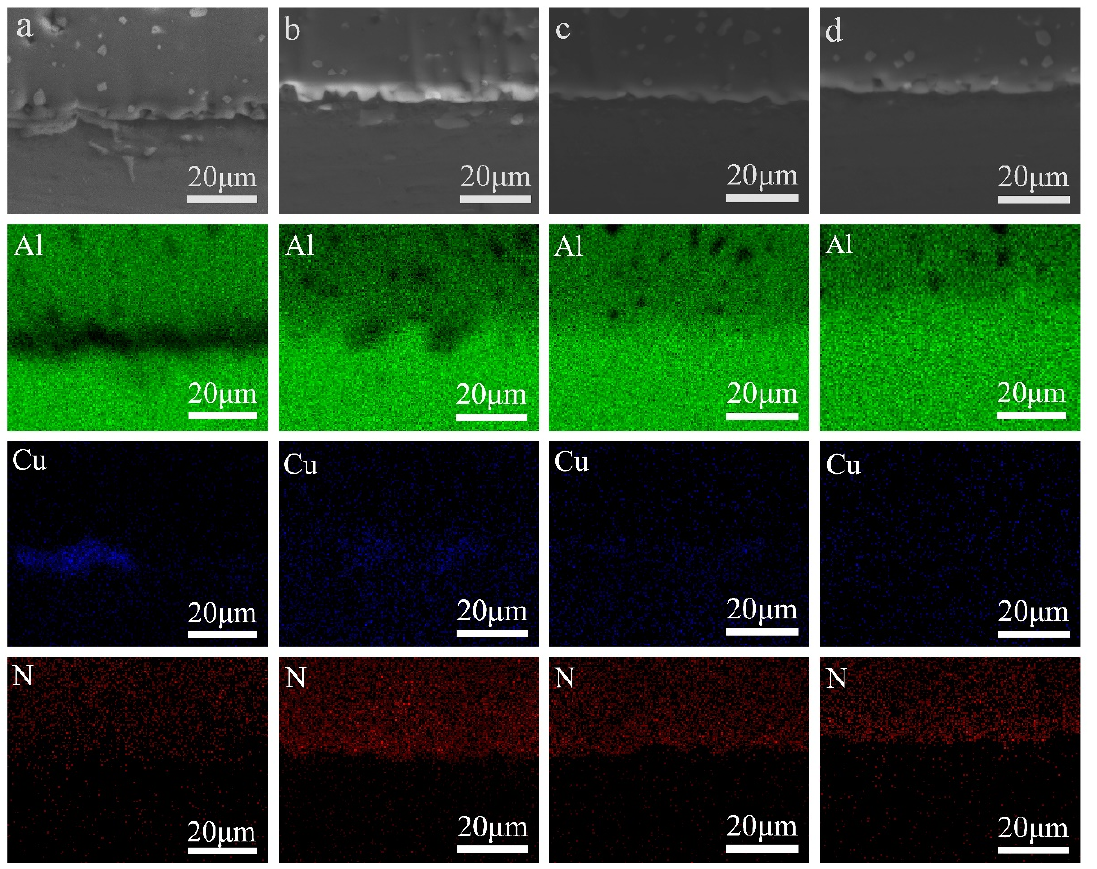
Figure 6. Scanning electron microscope images and scanning results of Al, Cu and N elements of brazed joints at different temperatures ( a ) 600 °C; ( b ) 620 °C; ( c ) 640 °C; ( d ) 660 °C.